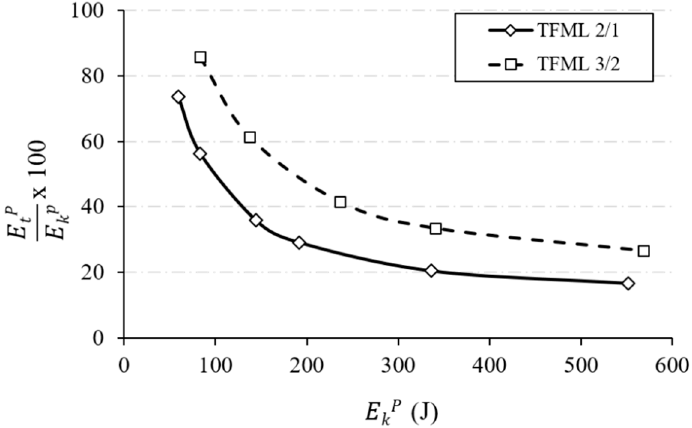
Figure 4. Effect of the TFML stacking configuration on projectile kinetic energy change for the range of incident impact energy.